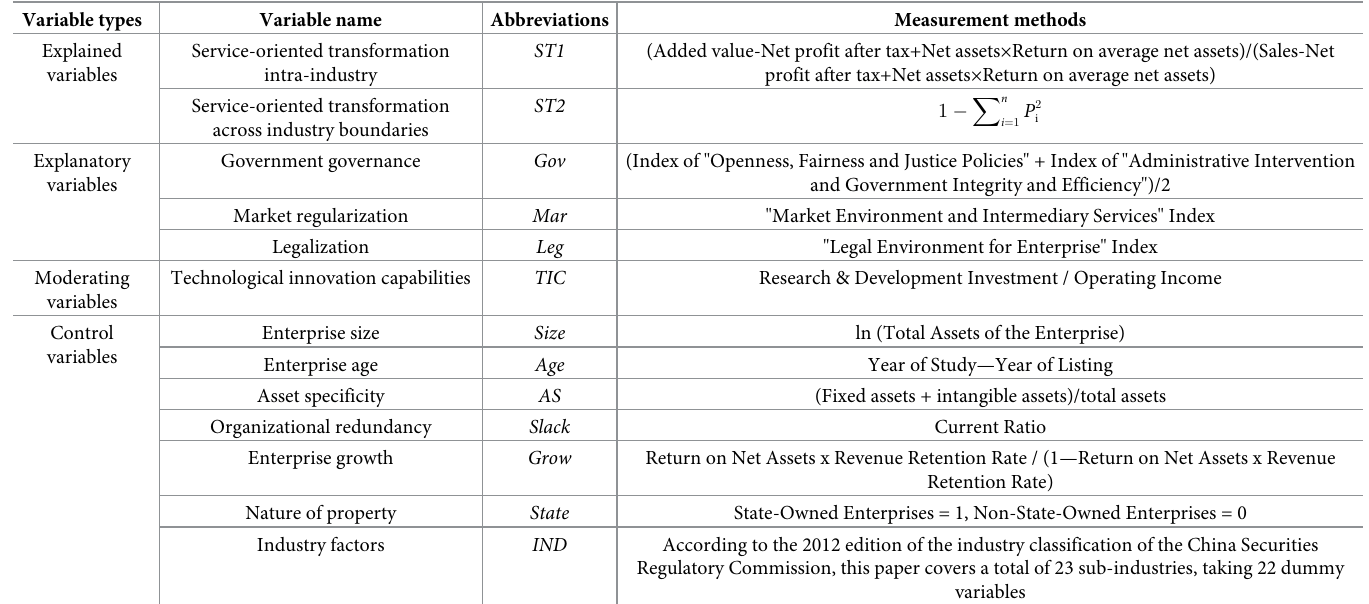
Table 1. Variable names, variable abbreviations and measurement